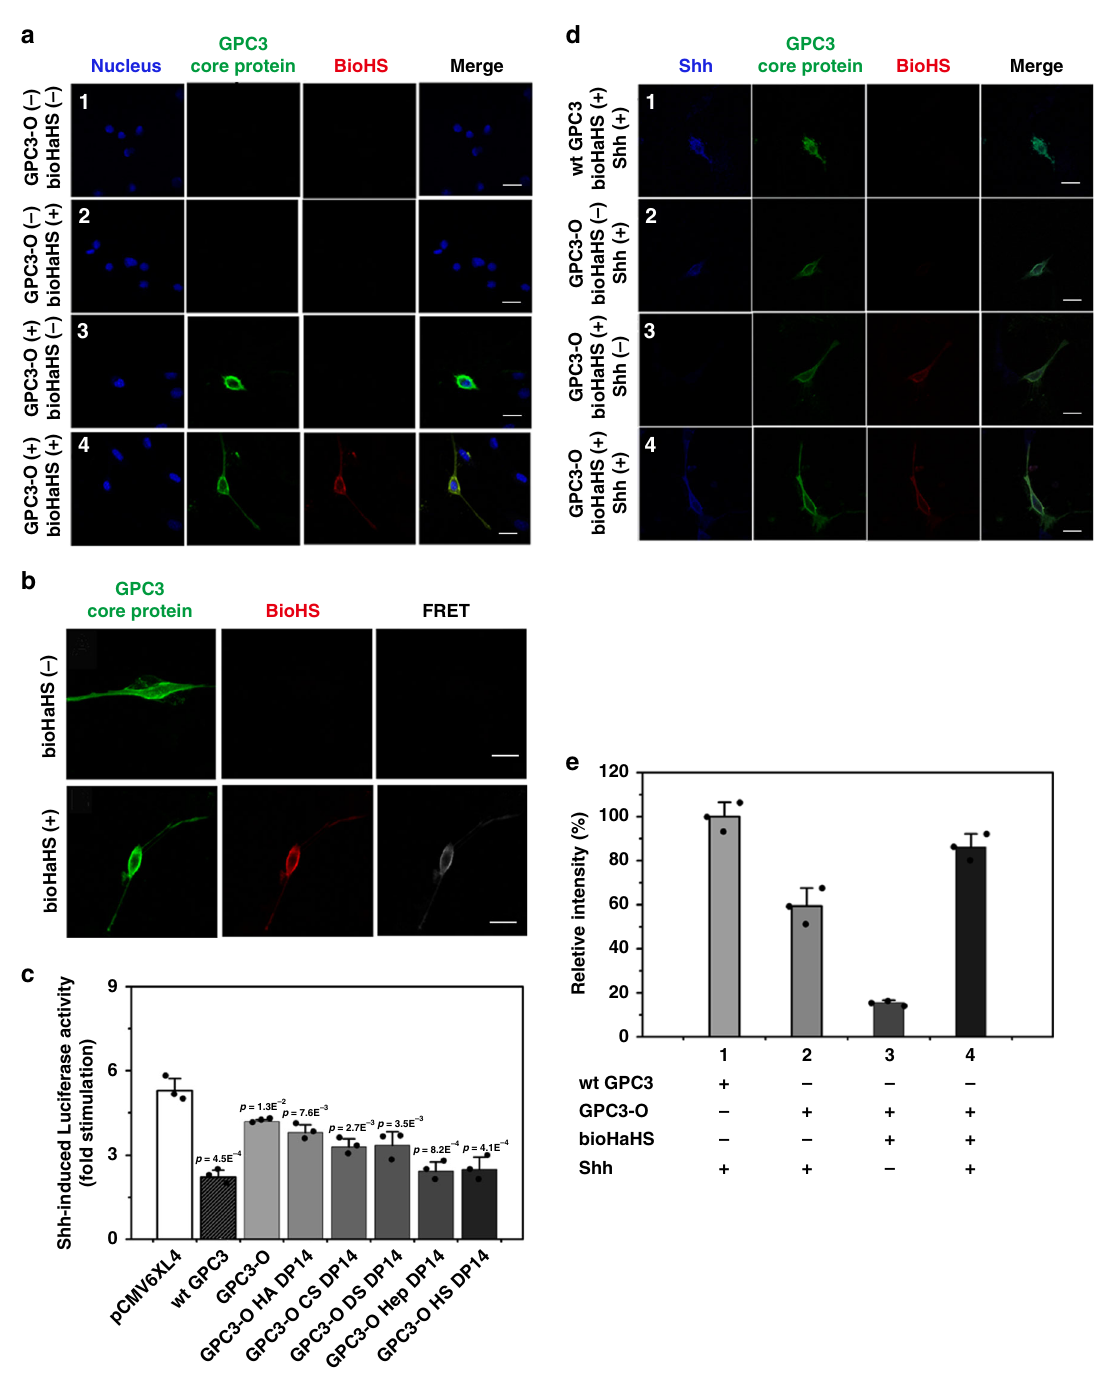
Fig. 5 Engineered GPC3 inhibits Shh signaling. a Fluorescence detection of GPC3 core protein and HS oligosaccharide chains in NIH3T3 cells. Cells transfected with engineered GPC3 (3,4) or negative controls (pCMV6XL4) (1,2) were incubated in the presence (2,4) or absence (1,3) of bioHaHS and were stained with a GPC3 antibody (GPC3) or TRITC-conjugated streptavidin. b Cells expressing engineered GPC3 were incubated with or without biotinylated HS, and FRET was performed. c NIH3T3 cells were transfected with GPC3-O or vector control (pCMV6XL4), and incubated with different types of GAG chains. A Hh luciferase reporter assay was then performed. Bars represent the fold stimulation induced by Shh. d Shh binds to GPC3-O- bioHS in the context of intact cells. 1, Wild-type GPC3 with Shh CM; 2, GPC3-O with Shh CM; 3, GPC3-O-bioHS with control CM; 4, GPC3-O-bioHS with Shh CM. e Relative fl uorescence intensity of Shh bound to the surface of NIH3T3 cells expressing wild-type (wt) or engineered GPC3. wt GPC3, wild-type GPC3. All experiments were repeated three times with similar results. Error bars represent means of triplicates ± SD. p -values in all cases are compared with the corresponding negative control pCMV6XL4. Scale bars: 20 μ m. Source data are provided in a Source Data fi